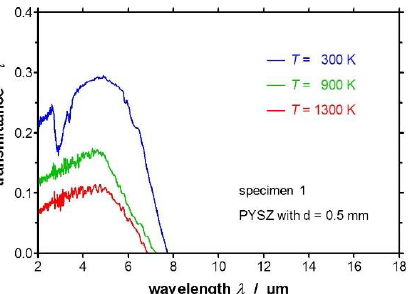
Figure 9. Transmittance of partially yttria-stabilized zirconia (PYSZ) at different temperatures with a thickness of 0.5 mm [48]. Reprinted with permission from [48]. Elsevier, 2017. thickness of 0.5 mm [48]. Reprinted with permission from [48]. Elsevier,